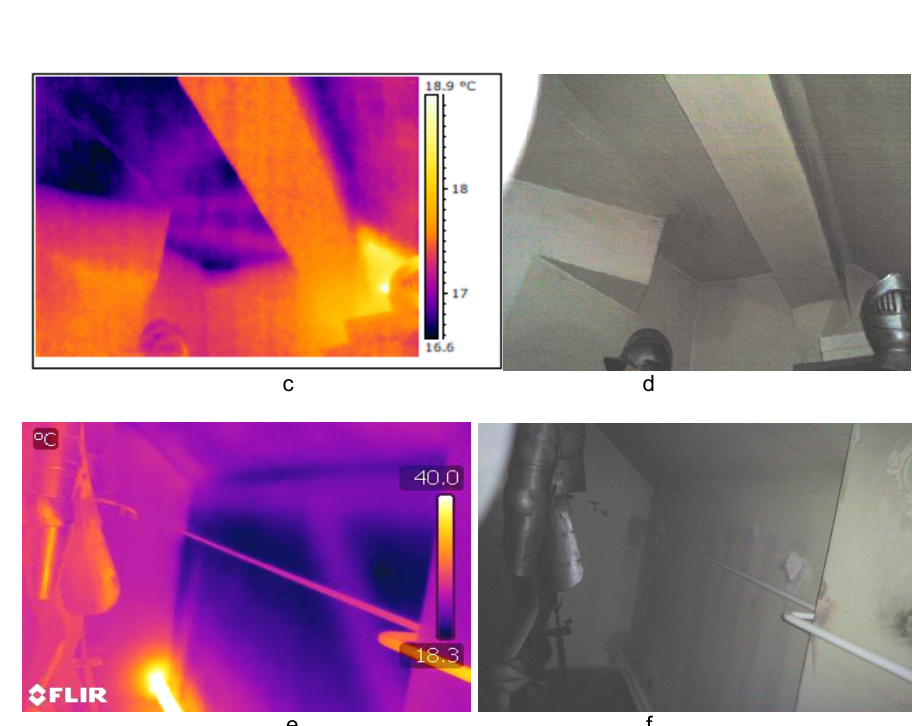
Figure 9 – Depot of old metal artifacts, a,b – side wall, c,d – roof, e,f – wall of the depot with the collection of non-European weapons Slika 9 – Depo zbirke starih metalnih eksponata, a,b-bo č ni zid, c,d – krov, e,f – zid